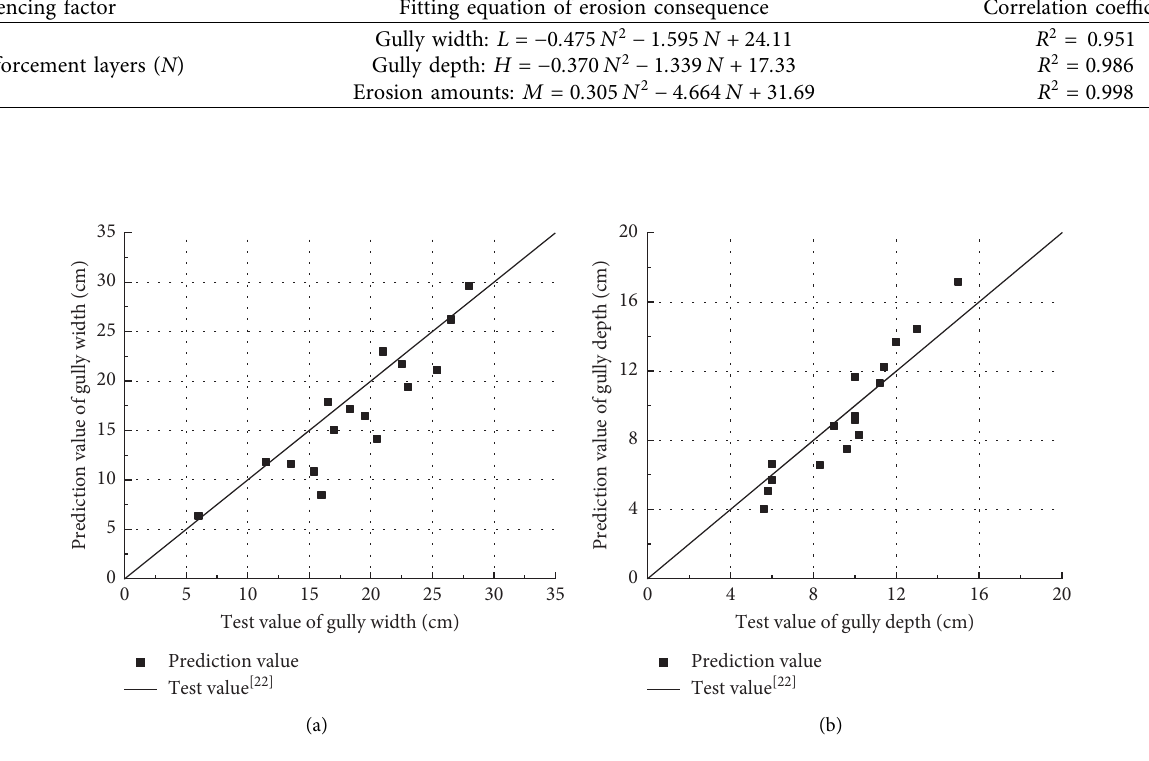
Figure 11: Verification and comparison of prediction models: (a) comparison of gully width; (b) comparison of gully depth.